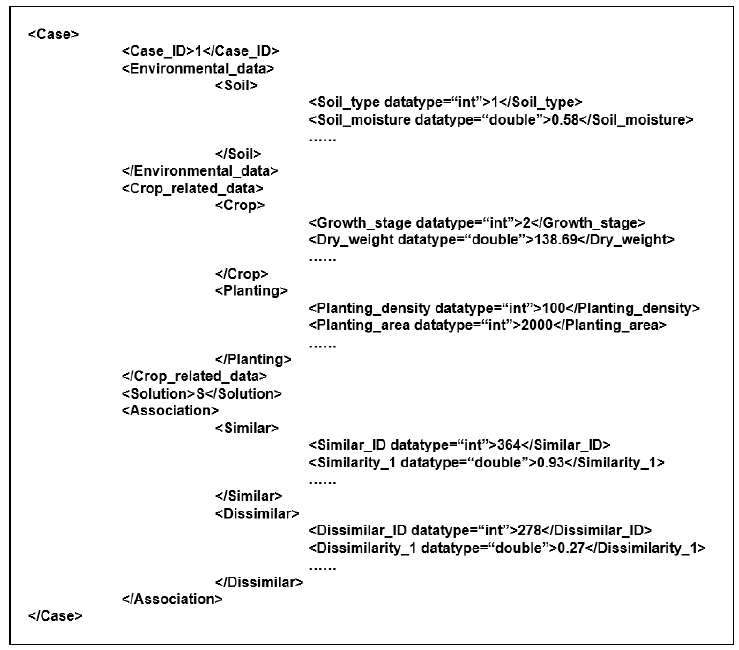
Figure 7. The structure of the associated case representation.